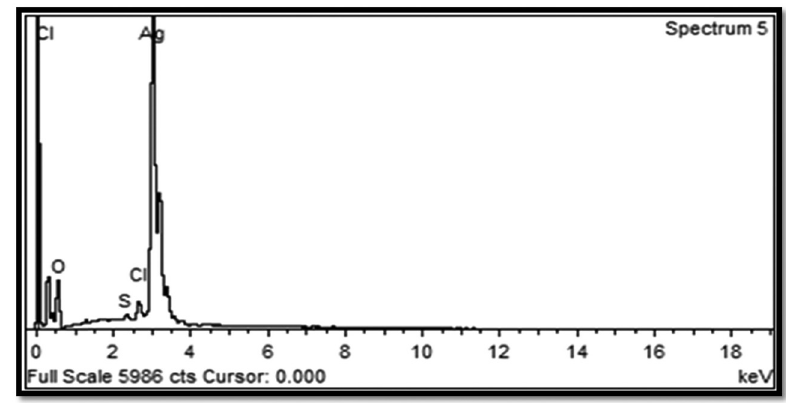
Figure 5: Elemental analysis of AgNPs showing presence of silver